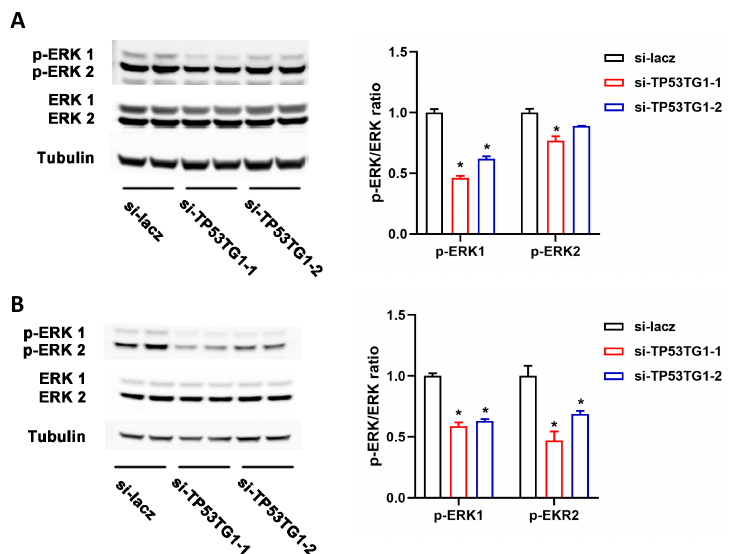
Figure 4. Knockdown of TP53TG1 inhibits ERK signaling. ( A , B ) Protein expression level (left) and quantification (right) of p-ERK1/p-ERK2 and ERK1/ERK2 in HepG2 cells ( A ) or PLC/PRF/5 cells ( B ) transfected with lacz siRNA or TP53TG1 siRNAs. The protein expression levels of p-ERK1 and p-ERK2 were normalized to ERK1 and EKR2, respectively. Error bars represent SEM, * p < 0.05 (si-RNA vs. si-lacz).